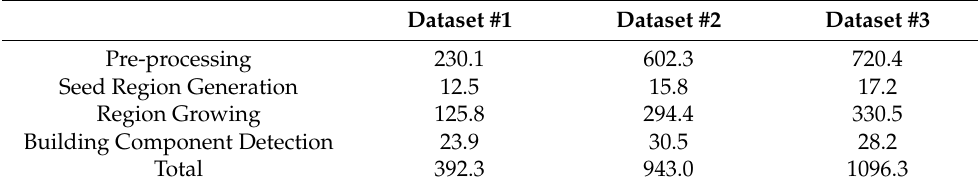
Table 6. Running time for processing steps of Dataset #1, #2, and #3. (Unit: